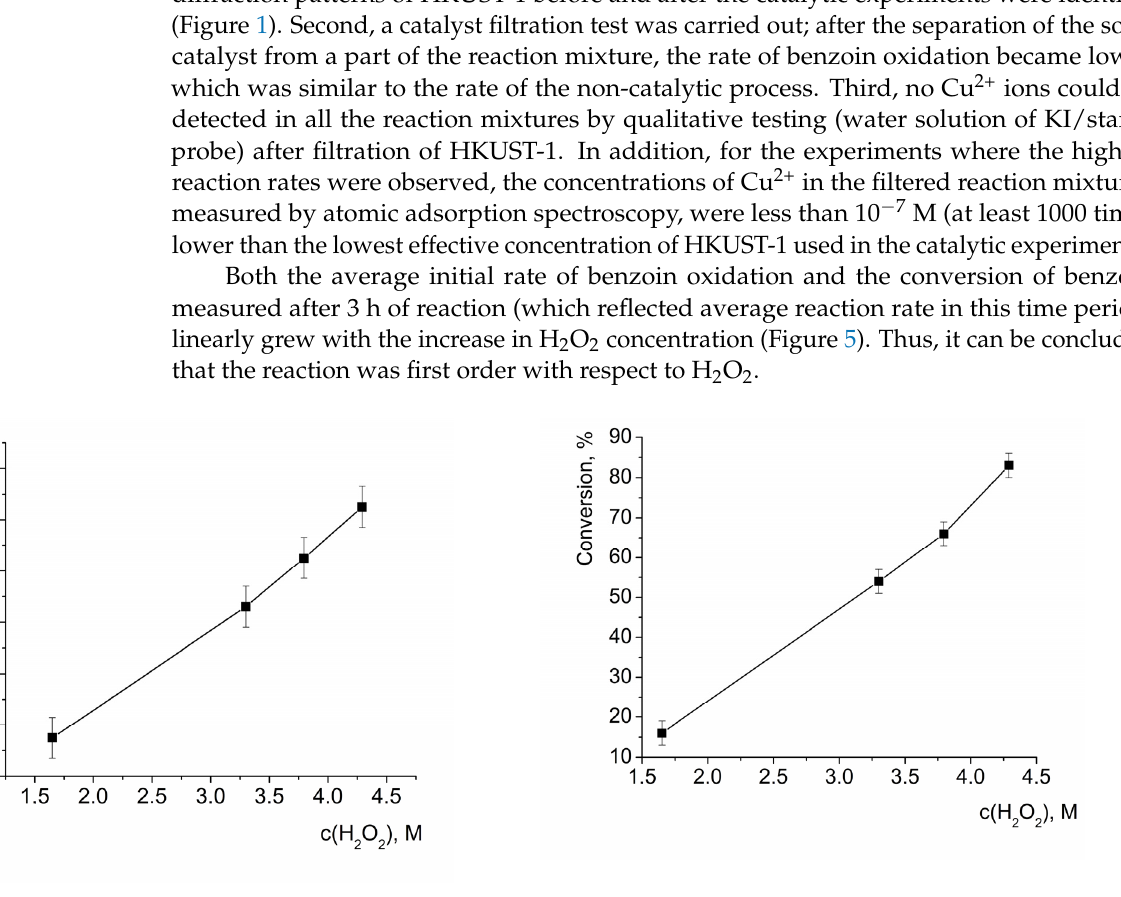
Figure 4. Catalytic oxidation of benzoin and substituted benzoins with excess of H 2 O 2 in the presence of HKUST-1.